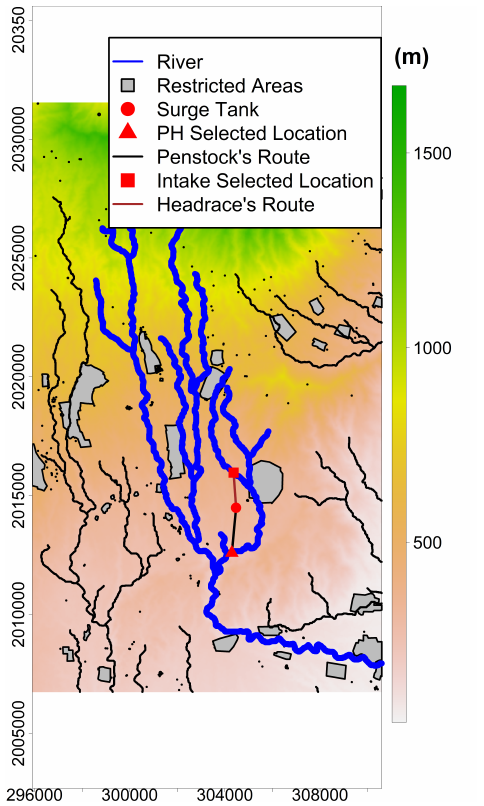
Figure 2. Run of River scheme includes the intake, the surge tank and the